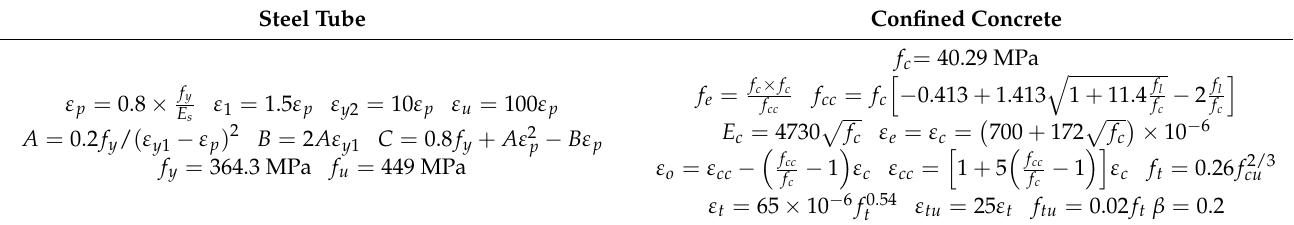
Table 5. Constitutive model parameter selection.